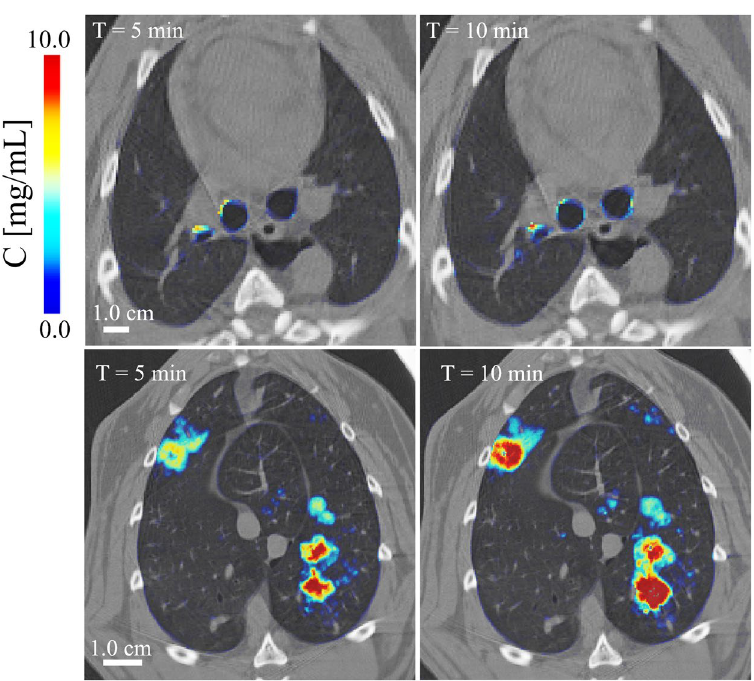
Figure 9. Composite cross-sectional images showing lung morphology and iodine deposition in central conducting airways ( top ) and in the lung periphery ( bottom ) after 5 and 10 min of aerosol inhalation, in one control